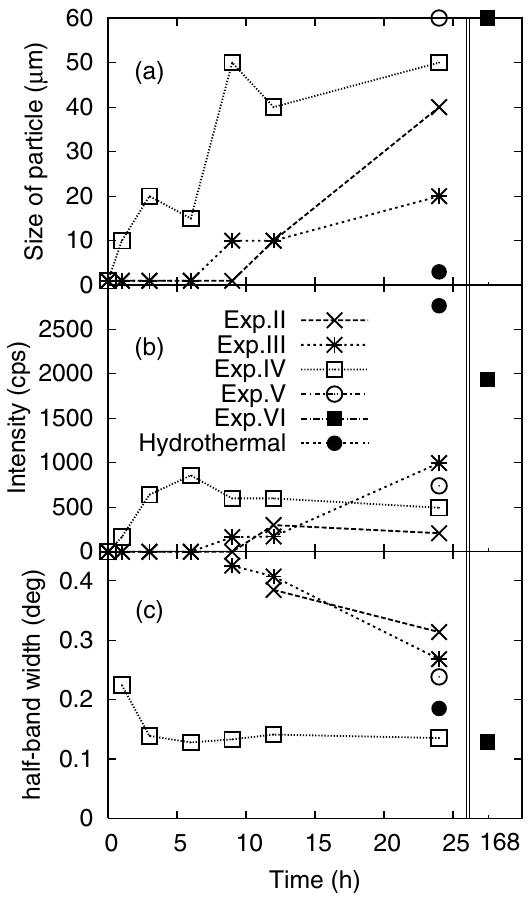
Figure 10. The transitions of (a) the particle size, (b) the XRD peak intensity, (c) the half-band width of the peak at 2(cid:2) D 19:8 ı